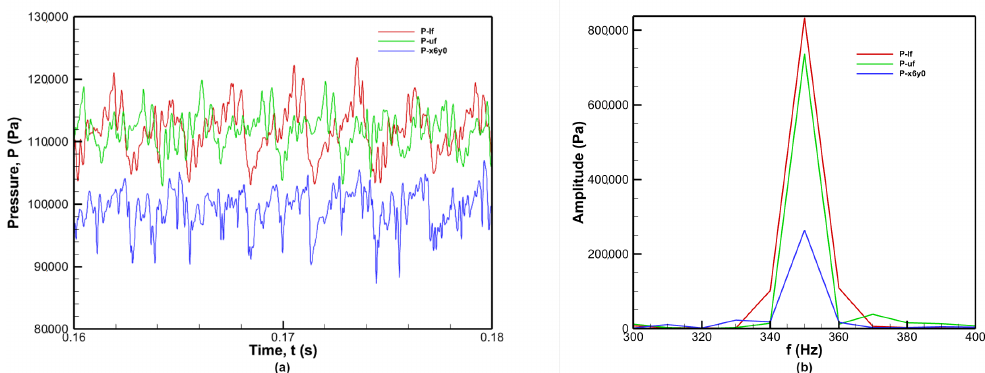
Figure 4. ( a ) Time history at three different locations (P-uf), (P-lf), and (P-x6y0) showing the pressure amplitude for N-60 (only the clipped portion of the sample) and corresponding FFT analysis ( b ) at those sampling locations where peaks indicate the oscillation frequency, respectively.